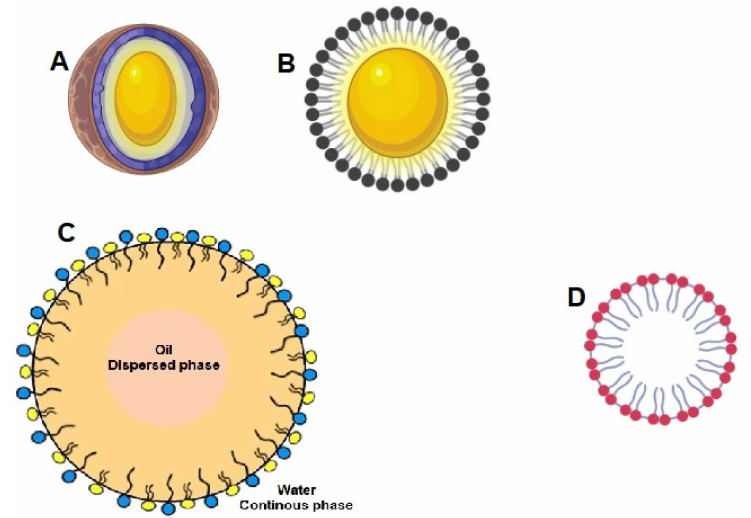
Figure 5. Schematic representation of the various unilayered lipid-based nanocarriers. Nanocapsules ( A ); SLN/NLC ( B ); Nanoemulsion ( C ); and Micelle ( D